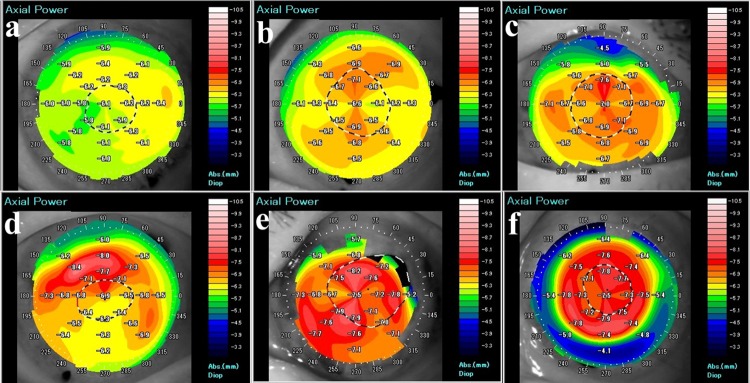
Posterior color grade after endothelial keratoplasty.Using anterior segment optical coherence tomography (AS-OCT), the posterior classification is used to score the cornea from 0 to 5 points according to PRP.
(A) Grade 0: Background consists of “cool” colors (green or blue).(B) Grade 1: Background is yellow.(C) Grade 2: Background is orange and total area of red is < 1/4(D) Grade 3: Background is orange and 1/4 < total area of red is < 1/2.(E) Grade 4: Background is orange and total area of red is > 1/2.(F) Grade 5: Background is red.